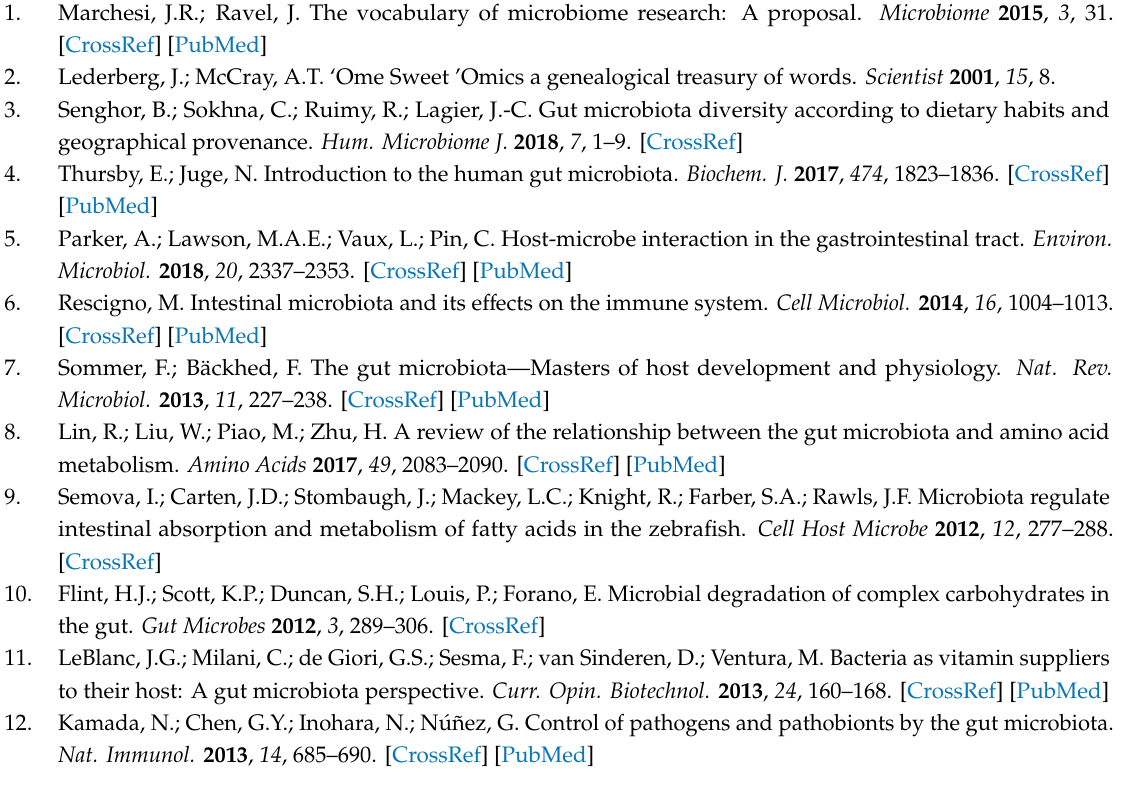
R 2 = 0.163, p = 0.051; O group mid intestine and tank biofilm bacteria ( G ): F-statistic = 3.910, R 2 = 0.206, p = 0.03. Figure S3: Double principal coordinate analysis plots showing the di ff erences in the composition of the core bacterial communities in the intestine mucus of Atlantic salmon. The data in the ellipse-enclosed areas come from a multivariate normal distribution. Distal intestine ( A ): F-statistic = 2.061, R 2 = 0.120, p = 0.082 and mid intestine ( B ): F-statistic = 2.061, R 2 = 0.120, p = 0.082 samples of the antibiotic-fed and control-fed groups. Figure S4: Single-domain network graph of the bacteria in the intestine mucus of Atlantic salmon. Distal intestine (4 A ) and mid intestine (4 B ) of the three fish groups. Phyla in di ff erent nodes are color-coded. The three panels represent the three feed groups: Control ( A ), F-fed ( B ), O-fed ( C ). Figure S5: Histograms showing the degree distribution of the bacterial networks associated with the intestine of Atlantic salmon. Distal intestine (5 A ) and mid intestine (5 B ). FigureS6: Summary of the main findings in the study. DI, distal intestine; MI, mid intestine; C, control group; F-fed and O-fed, antibiotic-fed